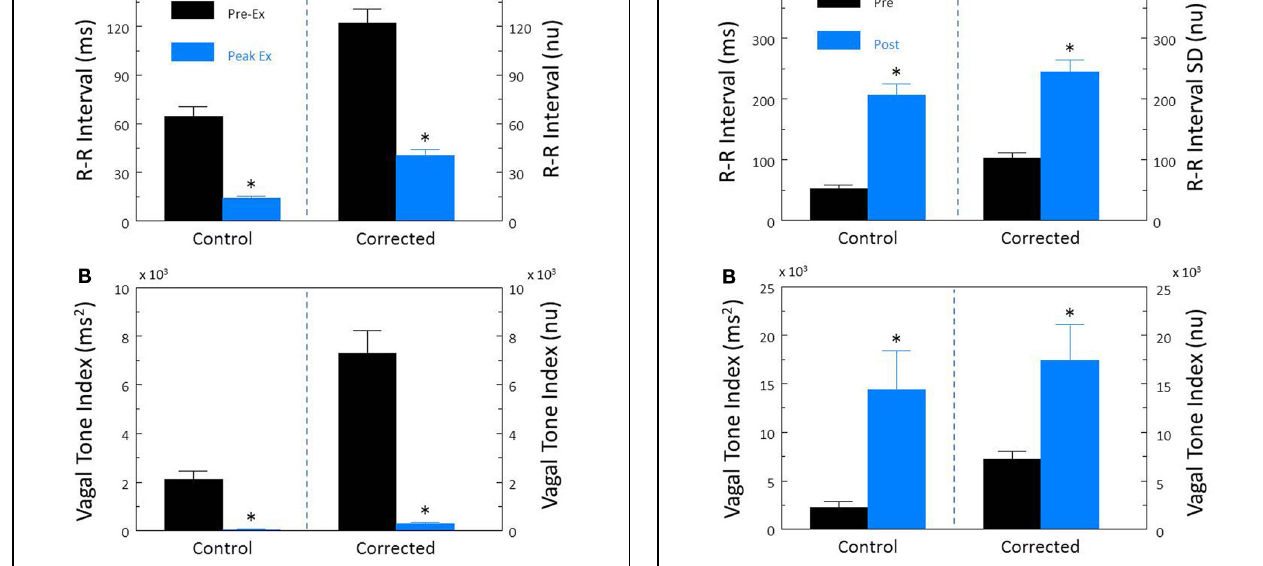
FIGURE 7 | Effect of submaximal exercise on heart rate variability. The effect of exercise ( n = 25) on total heart rate variability (standard deviation of R-R interval, RRSD) without and with correction (RRSD/mean RRsec) is displayed in (A) . The effect of exercise on the high frequency variability (cardiac vagal tone index, 0.24–1.04 Hz) without and with correction [cardiac vagal tone/(mean RRsec) 2 ] are shown in (B) . Note that despite correction for large increases in heart rate, exercise provoked even large reductions in both RRSD and the cardiac vagal tone index than were noted before correction. The data were averaged over the last 30s before exercise onset (Pre-Ex, black bars) and during the last 30s of exercise (Peak Ex, blue bars) level. Peak exercise = 6.4kph and 16% grade. ∗ P < 0 . 01 Pre-Ex vs. Peak Ex. nu, normalized units following HR correction.